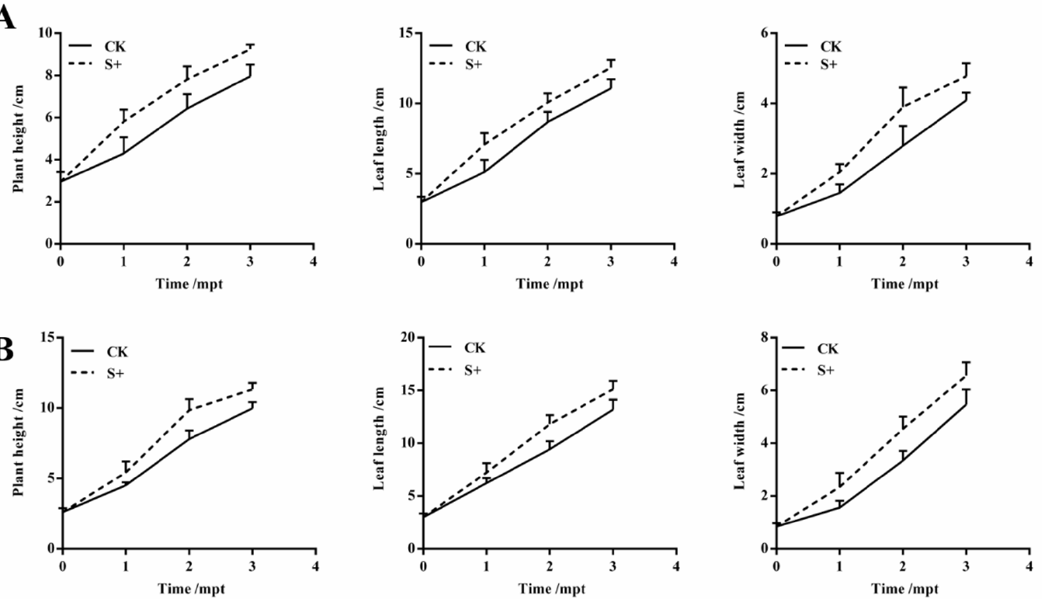
Figure 2. Effects of S. indica on the plant height, leaf length, and leaf width of ‘Zhongjiao No.3’ ( A ) and ‘Zhongjiao No.4’ ( B ) banana seedlings. CK: S. indica non-colonized controls; S+: S. indica colonized banana seedlings. Table 1. Effects of S. indica on the growth indexes of ‘Zhongjiao No.3’ (ZJ3) and ‘Zhongjiao No.4’ (ZJ4) banana seedlings. CK: S. indica non-colonized controls; S+: S. indica colonized banana seed- lings. The different letters in the same column represent significant difference among samples at 0.05 level.